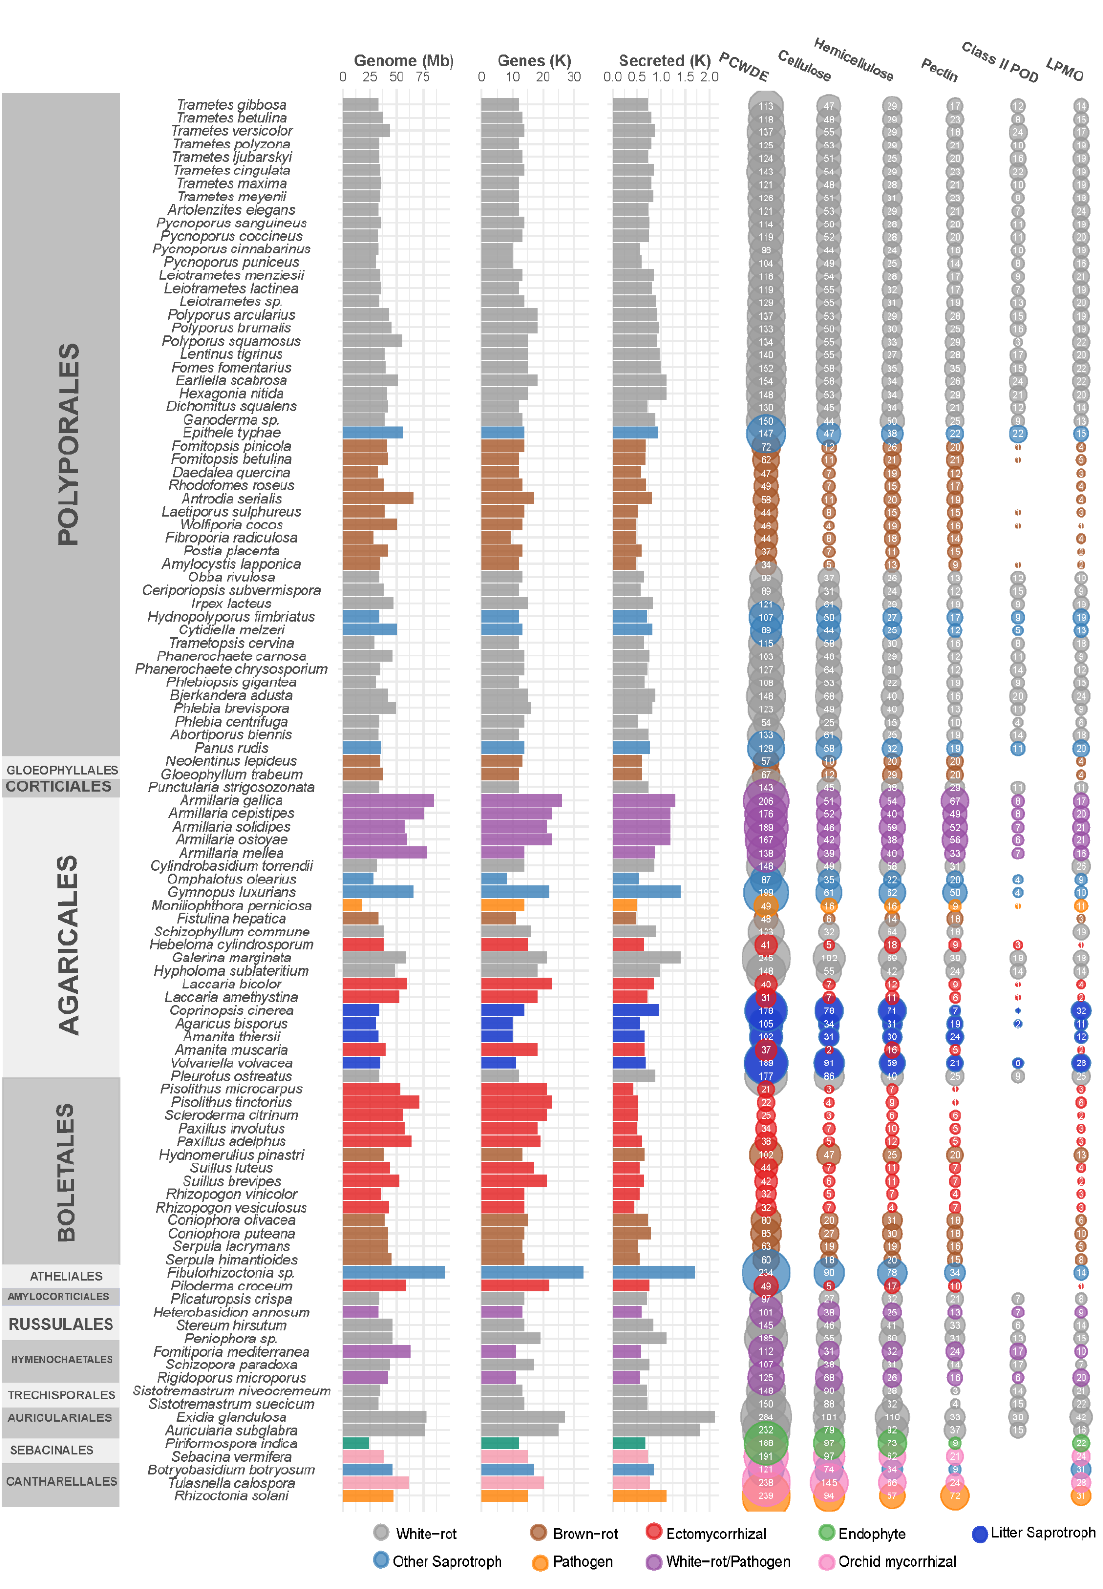
Figure 2. Genomic features of 107 Agaricomycetes and gene counts for secreted enzymes active on cellulose, hemicellulose, or pectin, and for Class II peroxidases and lytic polysaccharide monooxygenases (LPMOs) AA9, AA10, AA13, and